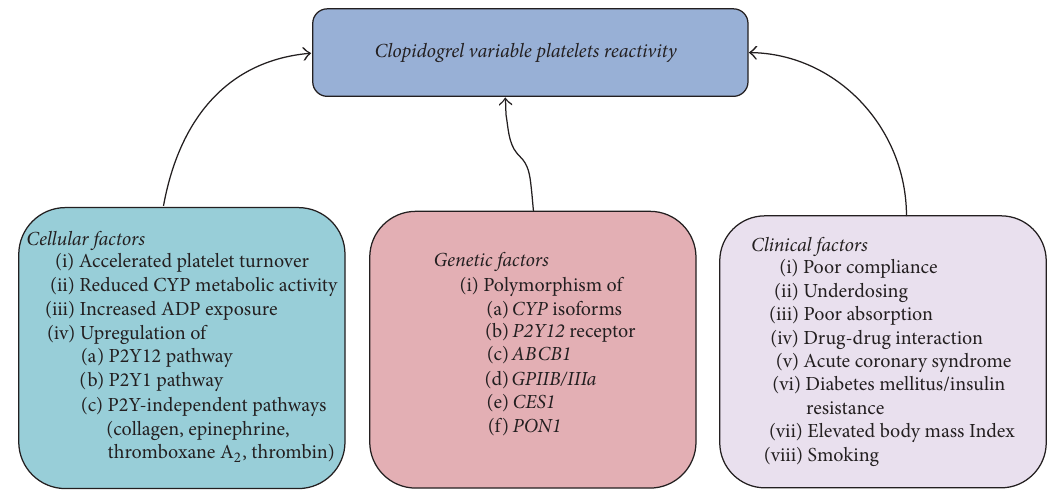
Figure 1: The genetic and nongenetic factors which may contribute to clopidogrel variable platelets reactivity. The figure presents the known geneticandnongeneticfactors(cellularandclinicalfactors)whichmaycontributetoclopidogrelvariableplateletsreactivity. CYP :cytochrome P450, ADP: adenosine diphosphate, GPIIB/IIIa: Glycoprotein IIB/IIIa, ABCB1: ATP-Binding Cassette Subfamily B Member 1. This figure is adapted and modified with permission from the publisher. Original source: Angiolillo and Ferreiro (2010) [85]. Copyright© (2010) Sociedad Espa˜nola de Cardiolog´ıa. Published by Elsevier Espa˜na SL. All rights